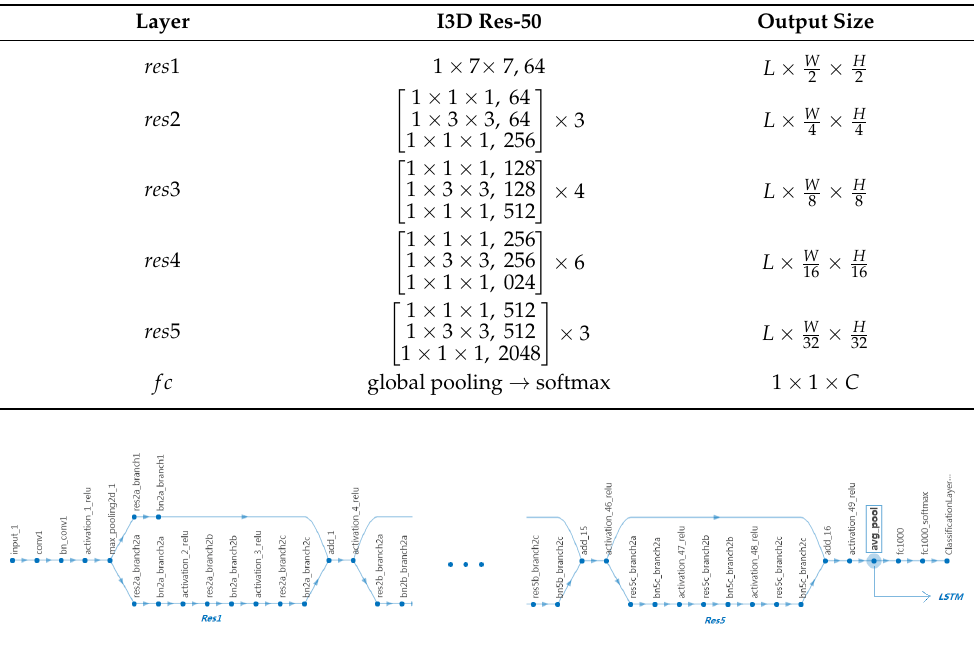
Figure 5. Res-50 backbone, 2nd, 3rd, 4th residual blocks are internally similar and are therefore omitted.